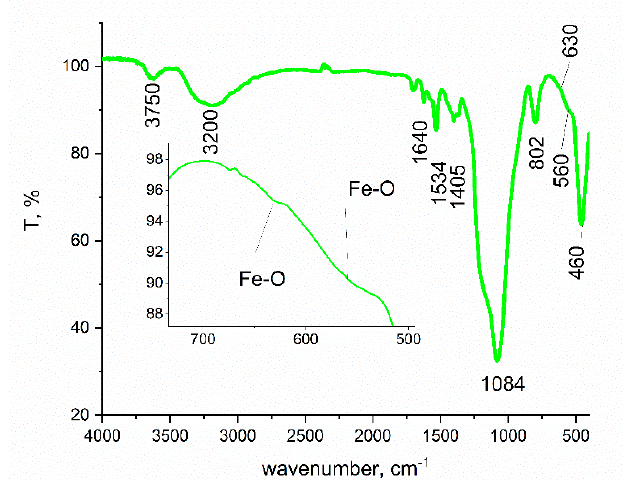
Figure 3. Fourier transform infrared spectroscopy (FT-IR) spectra of xerogel sample, SiO 2 FexOy.